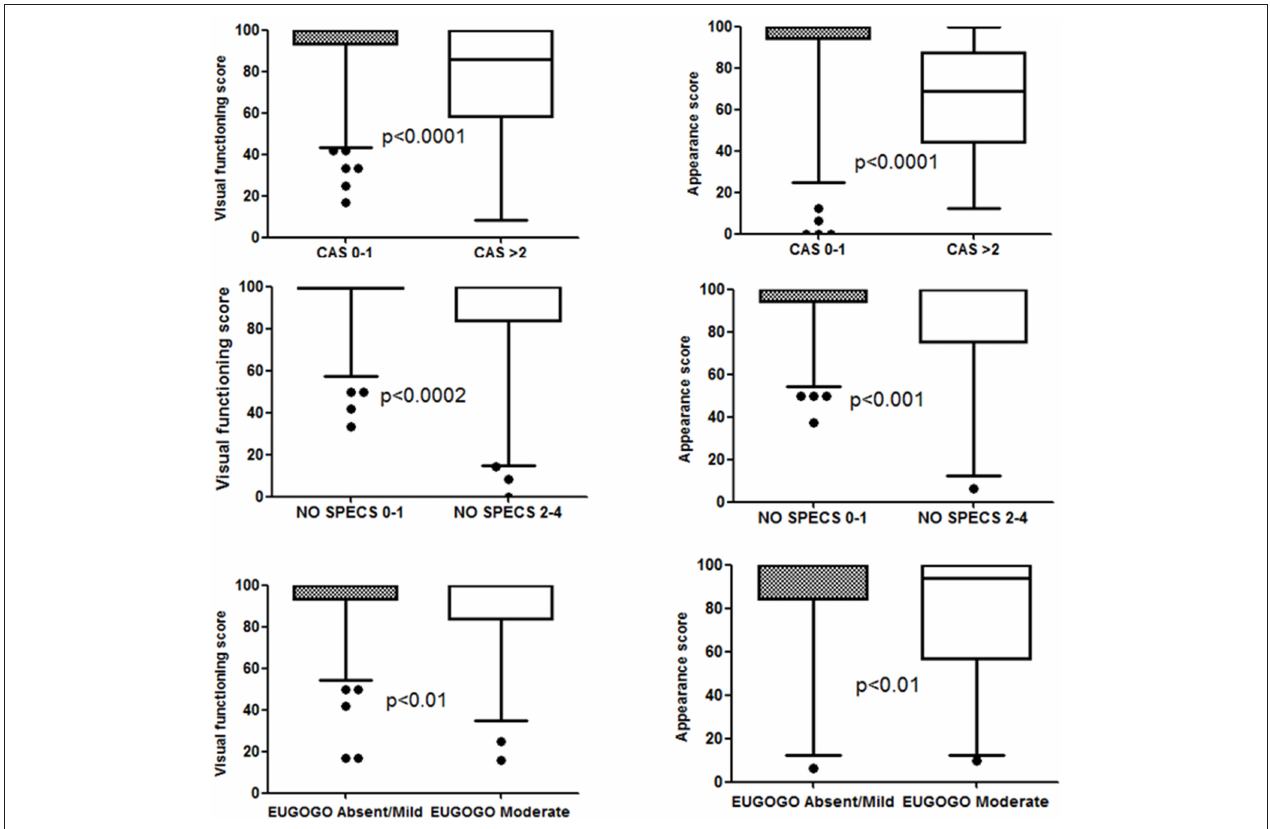
FIGURE 1 | The effect of clinical activity scores (CAS), NO SPECS scores, and EUGOGO scores on Graves’ ophthalmopathy quality of life (GO-QoL) scores of functional visual and appearance domains. The Mann–Whitney test was used for differences between the two groups. The box encloses the interquartile range, the median is marked by a line within the box, and the “whiskers” extend from the interquartile range to the 2.5 and 97.5 percentiles.